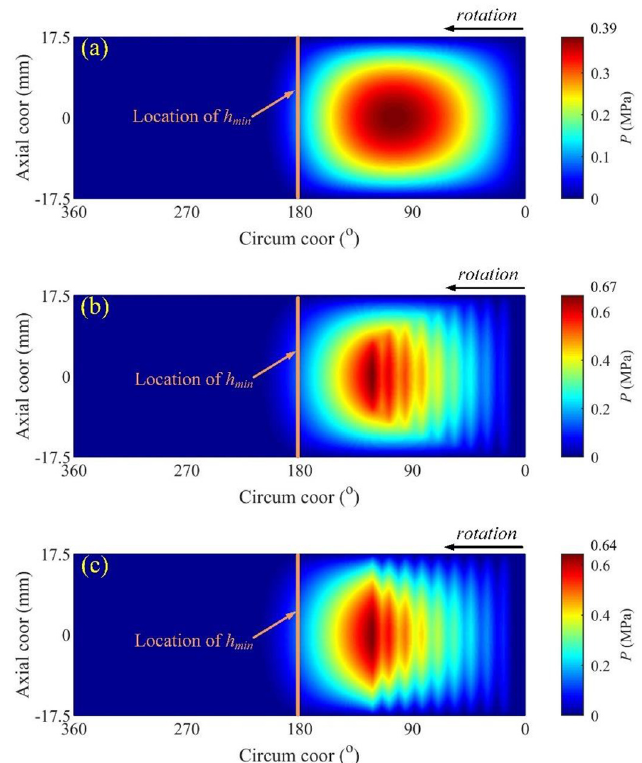
Fig. 8. Pressure distributions under e =0.1, ’ = 0 of (a) smooth bearing, (b) optimal textured bearing, (c) reference textured bearing.